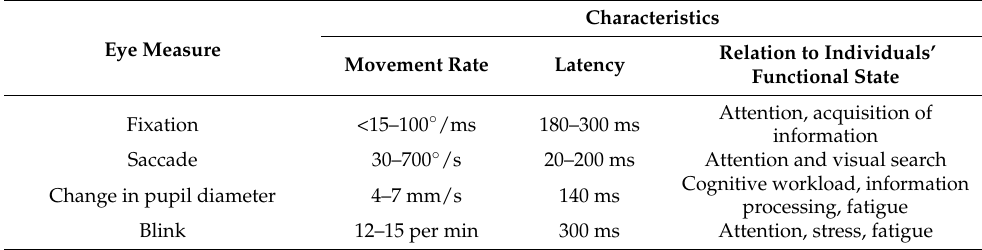
Table 4. Summary of eye metric